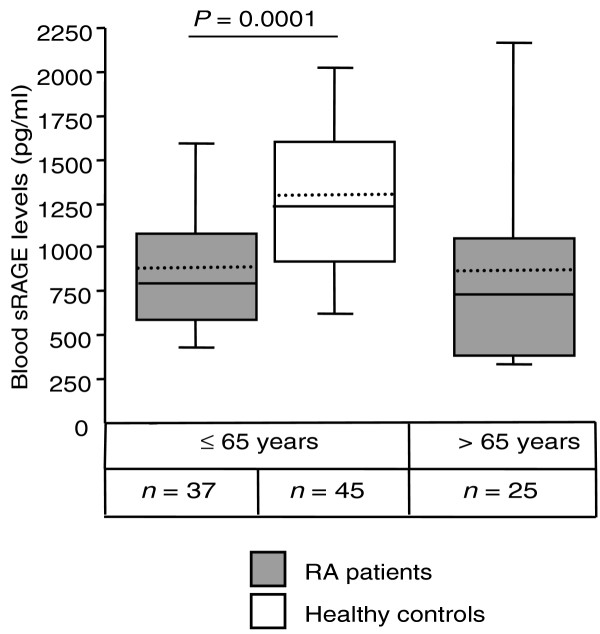
Blood soluble receptor for advanced glycation end products (sRAGE) levels in age-matched groups of rheumatoid arthritis (RA) patients and healthy controls. Box plots show the 25th and 75th percentiles. Horizontal lines within boxes in bold indicate medians, and dashed lines indicate means. Vertical bars indicate the 5th and 95th percentiles. Statistical differences with respect to sRAGE levels between groups were calculated using the Mann–Whitney U test.